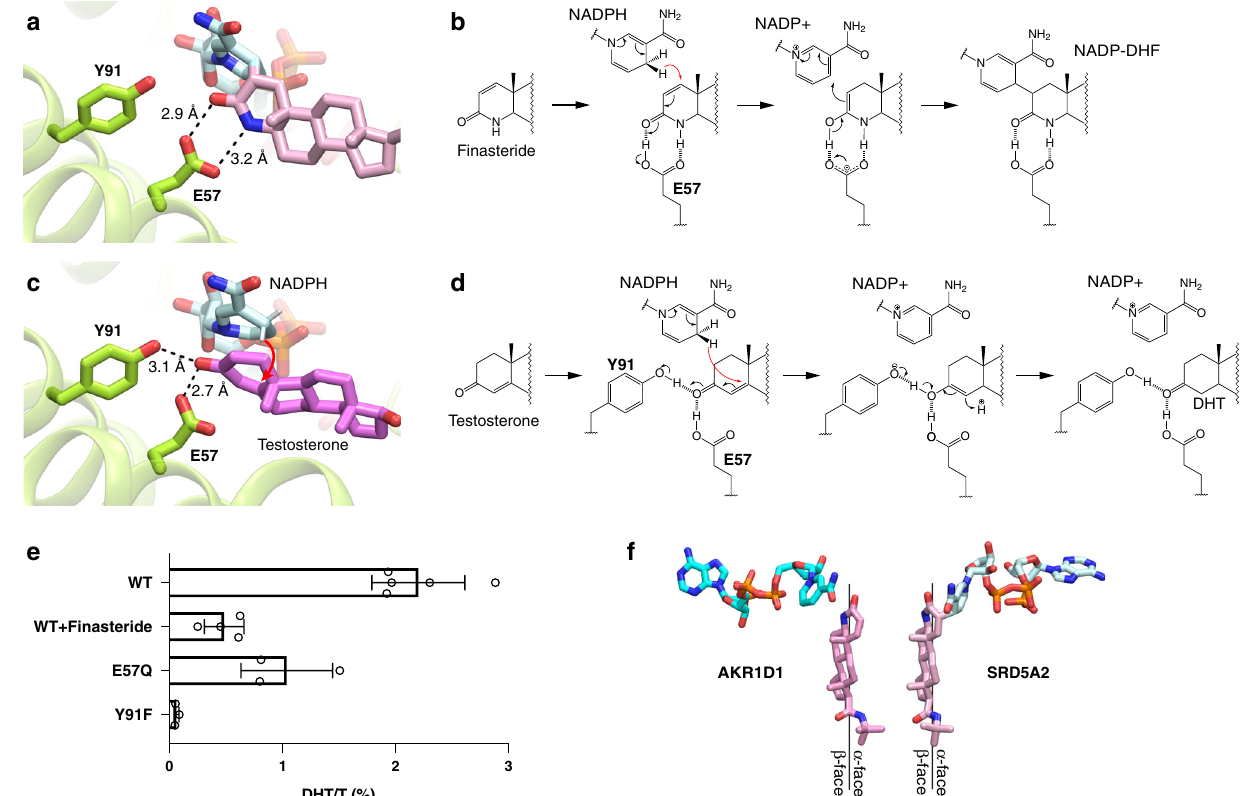
Fig. 3 Mechanisms of SRD5A2 catalysis and inhibition. a Binding pose of DHF. Y91 TM3 is not directly hydrogen bonded to DHF. b Potential mechanism of fi nasteride inhibition and the covalent adduct formation between NADPH and fi nasteride. E57 TM2 facilitates the hydride transfer to the Δ 1,2 bond of fi nasteride, leading to the formation of a covalent bond. c Binding pose of testosterone based on our docking results. E57 TM2 and Y91 TM3 each forms a hydrogen bond with the substrate. d Potential mechanism the 5 α -reduction of testosterone. E57 TM2 and Y91 TM3 facilitate hydride transfer to the Δ 4,5 bond of testosterone, leading to the formation of DHT. Hydrogen bonds are shown as dashed lines and the hydride transfer is shown as red curved arrows. e Catalysis of testosterone (T) to dihydrotestosterone (DHT) by wild-type SRD5A2 (WT), WT with 500 μ M fi nasteride, and two SRD5A2 mutants E57Q and Y91F. The ratios of DHT to T (DHT/T) were determined by mass spectrometry. All data are presented as the mean ± SEM of three (for E57Q and Y91F), four (for WT + fi nasteride), and fi ve (for WT) independent experiments. Source data are provided as a Source data fi le. f Distinct orientations of fi nasteride relative to NADPH in AKR1D1 and SRD5A2. The fi nasteride and NADPH conformations in the AKR1D1 structure (PDB ID: 3G1R) are shown by aligning the core ring of fi nasteride to that of DHF in the SRD5A2